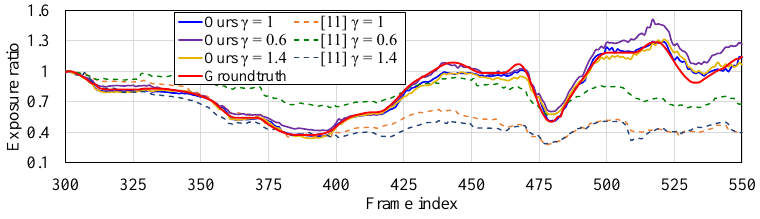
Figure 6. Ground truth of exposure time from a sequence capture by a stereo camera. Evaluated exposure times by Reference [11] and our method are compared with the ground truth.